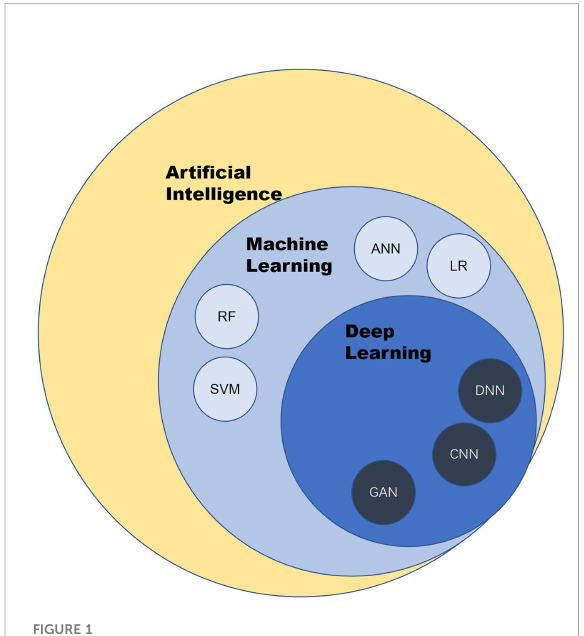
FIGURE 1 Overview of arti fi cial intelligence. ANN, arti fi cial neural network; CNN, convolutional neural network; LR, logistic regression; RF, random forest; SVM, support vector machine; DNN, deep neural network; GAN, generative adversarial